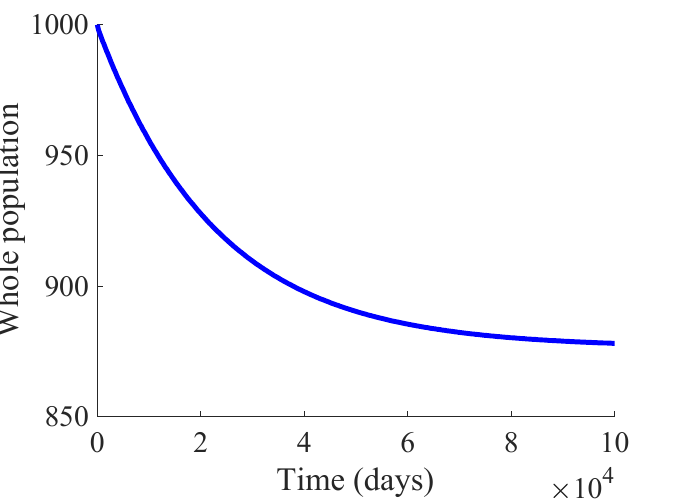
Figure 2. Time evolution of the whole population in the SIRS model without control actions.